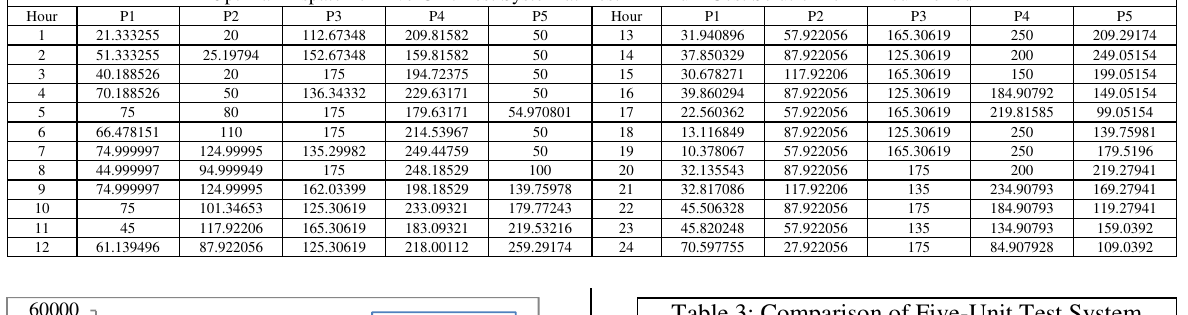
Table 3: Comparison of Five-Unit Test System with other Algorithms for Best Minimum Cost